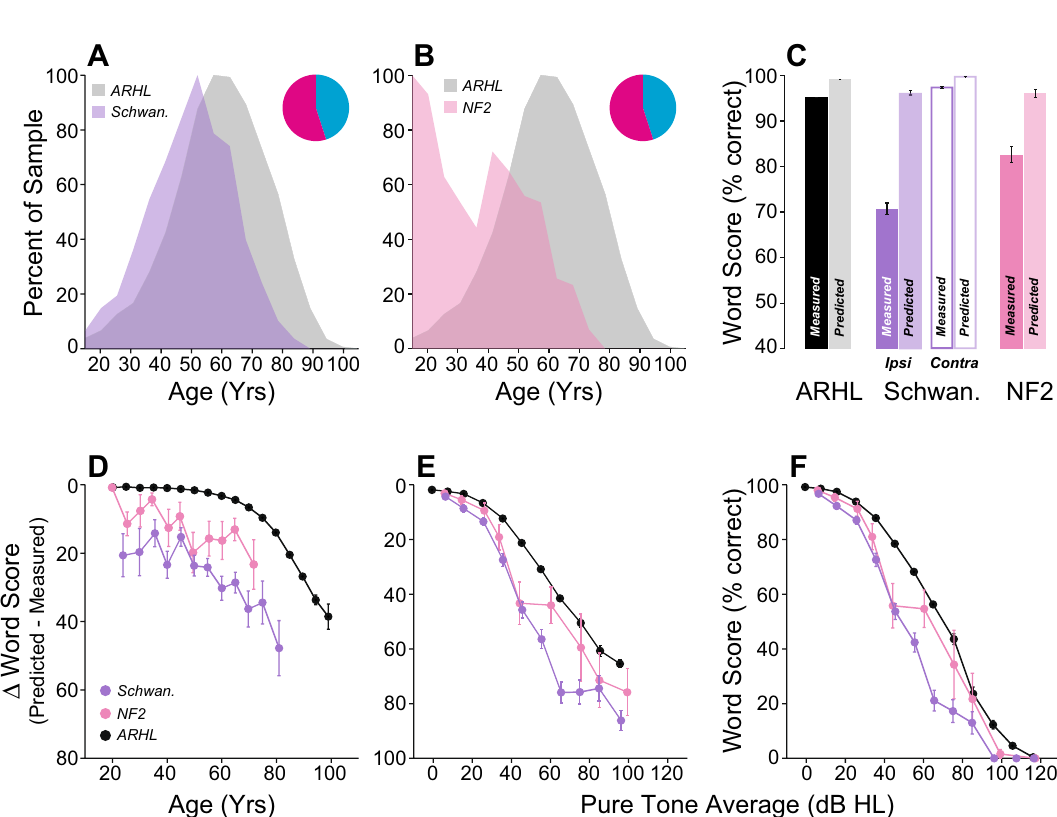
Figure 9. Intelligibility deficits in patients with diagnosed neuropathies are significantly worse than age- matched controls. ( A , B ) Age distribution of patients with Vestibular Schwannoma (Schwan.) ( A ) or Neurofibromatosis of type 2 (NF2) ( B ). Pie charts indicate the proportion of male (cyan) vs. female (magenta) for each group. ( C ) Comparison of mean WRS as measured in neuropathic patients or predicted by the speech intelligibility curve. Scores are compared across ears (ipsi vs. contra) and with patients presenting ARHL. ( D – F ) Speech Intelligibility deficits as a function of age ( D ) or pure-tone average ( E , F ). Legend in ( D ) applies to ( E – F